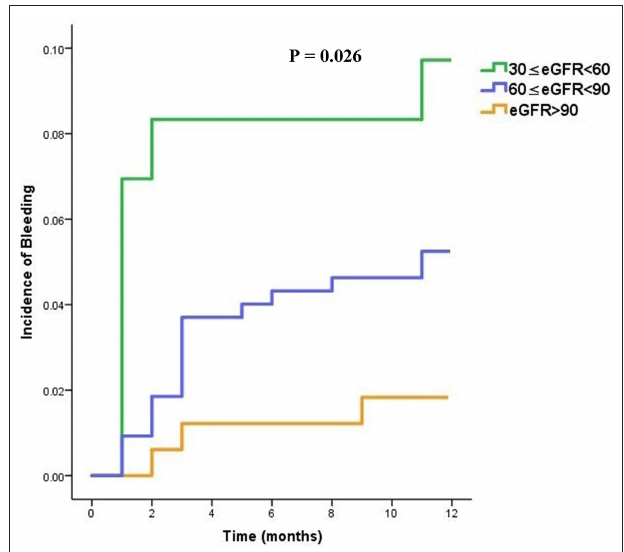
FIGURE 3 | Time to bleeding (TTB) curves in dabigatran treated patients, stratified into three subgroups (moderate, mild, and normal) according to the eGFR category.